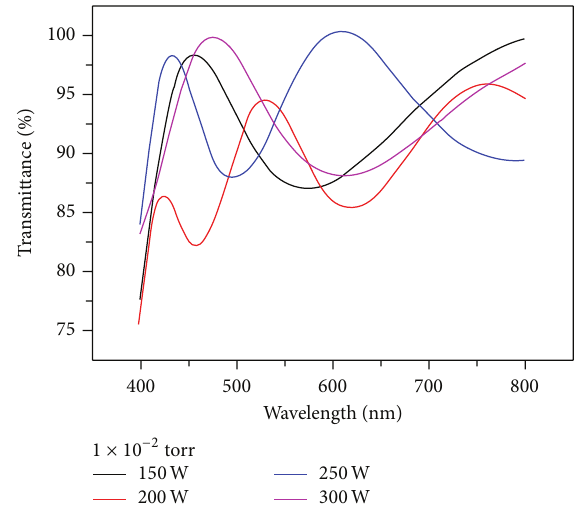
Figure 6: Transmittance spectrum for AZO films deposited at different working powers.